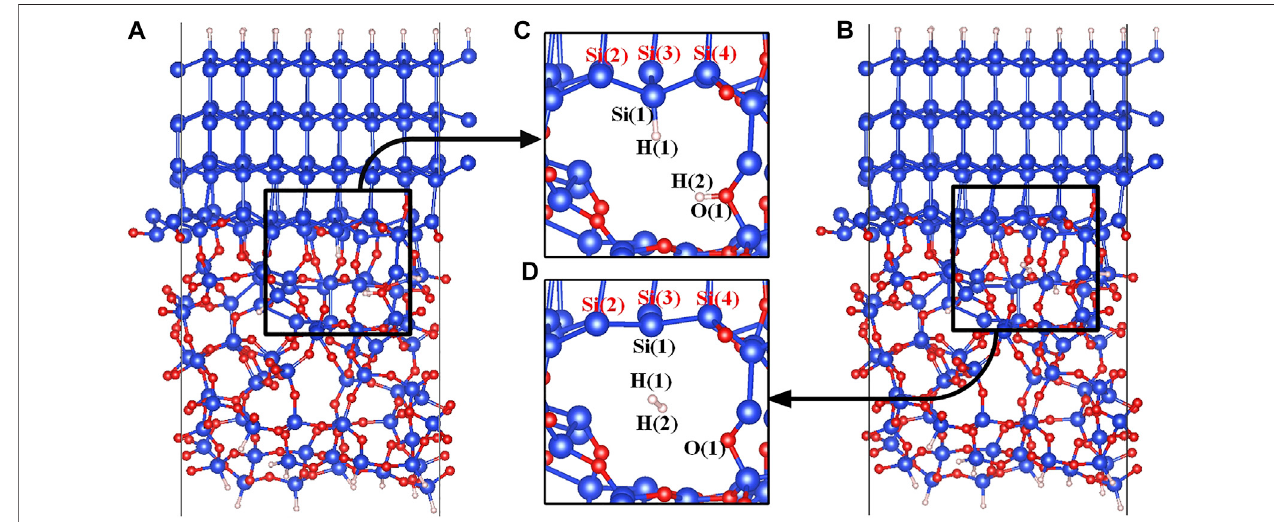
FIGURE 1 | (A) The initial state model of the a -SiO 2 /Si (111) interface, (B) The fi nal state model of the a -SiO 2 /Si (111) interface, (C) The initial state (state 00) partial fi gure ofthe P